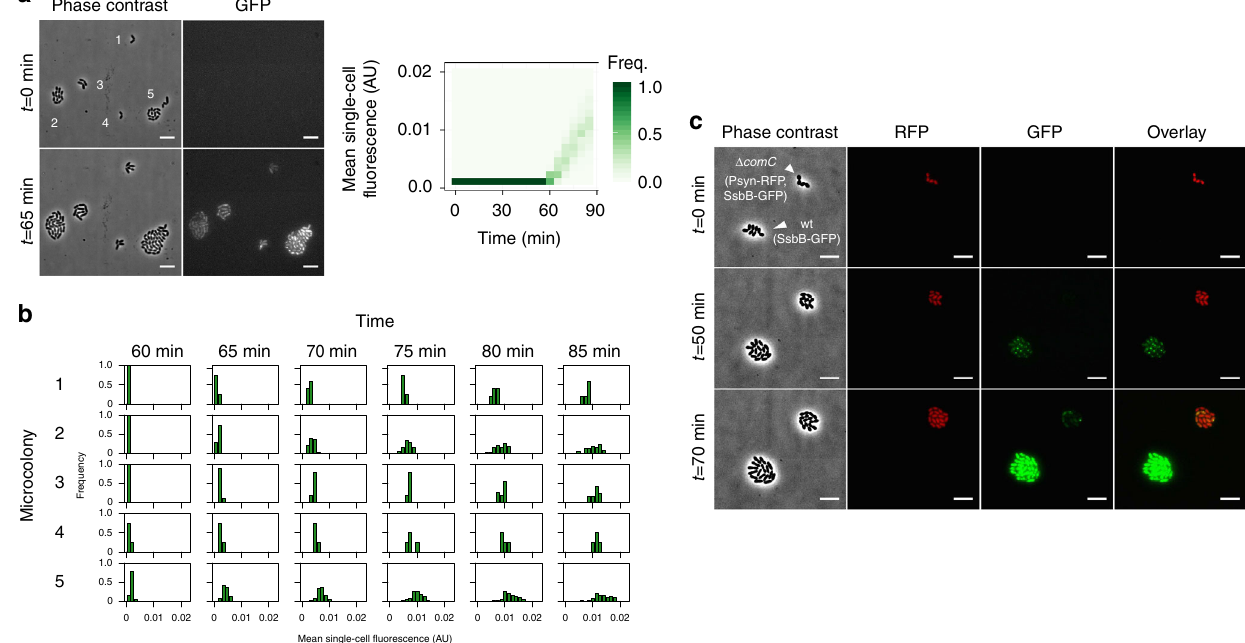
Fig. 3 Competence can propagate by CSP diffusion without the necessity of cell-to-cell contact. a Phase contrast and GFP images ( left panel ) of a set of neighboring microcolonies of D39 with a fusion of the late competence gene ssbB to gfp (P ssbB – ssbB – gfp ). The fi rst images ( t = 0 min) were taken right after inoculation on the microscopy slide and the second ones correspond to the moment of competence initiation ( t = 65 min). Images were taken every 5 min. Crucially, when competence starts the microcolonies are not in direct physical contact with each other. Analysis of the fl uorescence signal across the entire population ( right panel ) shows that once competence starts, after 60 min from inoculation, the distribution of fl uorescence intensity moves to higher intensity values through time. We set as a threshold for counting competent cells a fl uorescence signal 50% above background. After 85 min, we counted 97 out of 99 cells as competent cells. b Distribution of fl uorescence signal within each microcolony in the window of competence initiation. The microcolony numbers correspond to the ones indicated in the phase contrast image in a ). Competence initiates in all microcolonies within a window of 5 min. c Time-lapse fl uorescence microscopy tracking competence development in two colonies with a fusion of the late competence gene ssbB to gfp : one formed by cells of D39 (ADP249) and one formed by cells of a comC- de fi cient D39 (ADP247). The two strains are distinguishable because ADP247 constitutively expresses a red fl uorescent protein. Competence developed fi rst in D39 and then it propagated to the comC − mutant after 20 min without the necessity of cell – cell contact. Note that we checked that the comC -de fi cient D39 (ADP247) does not become competent by itself when grown without D39 (Supplementary Fig. 4 and Supplementary Movies 3 and 4). The scale bar is 5 µ m in all